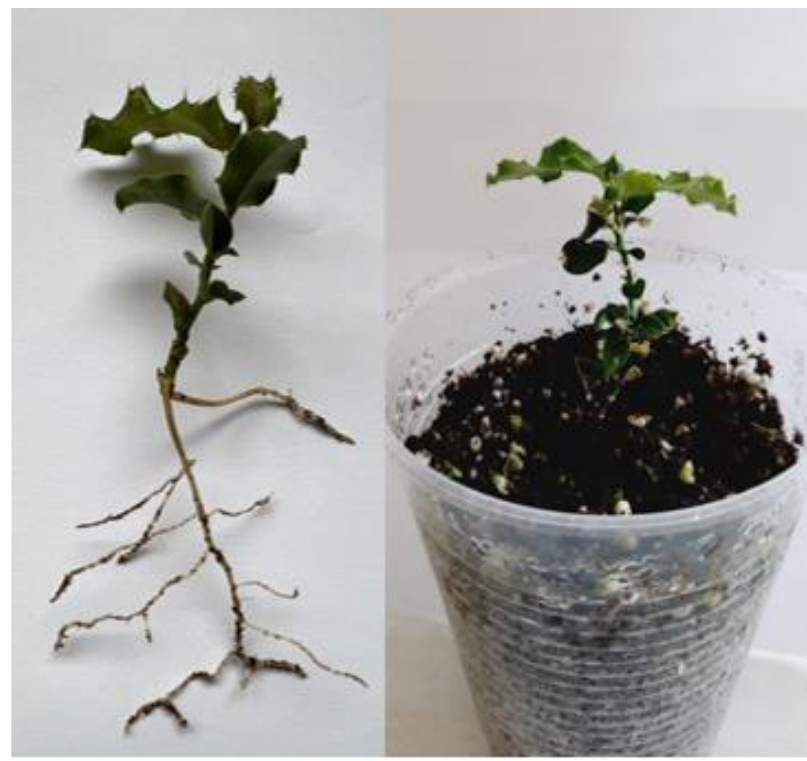
Figure 4. Rooted and acclimated C. mucronata plant.